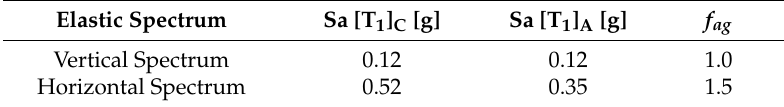
Table 3. Amplification factors due to site effects.